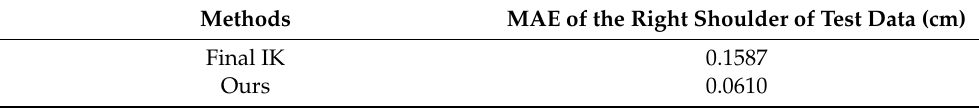
Table 3. MAE values of the right shoulder of the test